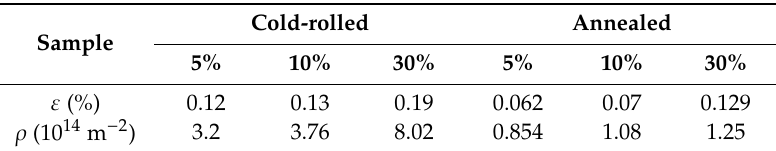
Figure 6. X-ray diffraction pattern of the AFA steel subjected to cold rolling at room temperature and annealing at 1150 °C for 30 min, respectively. Table 3. Microstrain and dislocation density in the samples of AFA